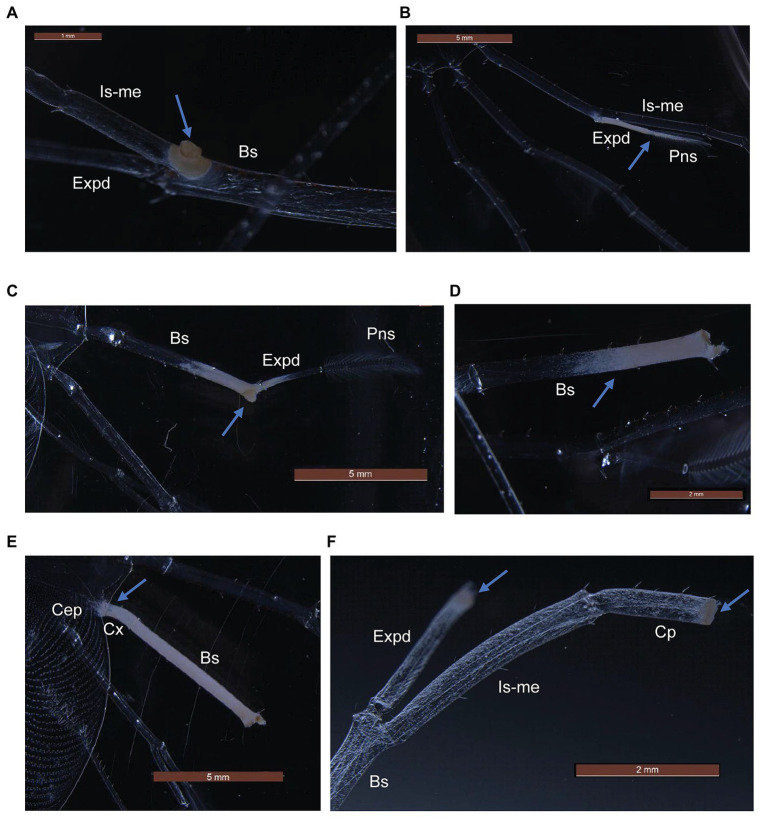
Gross pathological changes (arrows) during white leg disease (WLD) progression of P. ornatus
(A–E) and T. australiensis
(F) phyllosomas. (A) Pereiopod spot lesion at junction of basis (Bs), ischio-merus (Is-me) and exopod (Expd). (B) Advanced lesion of exopod and plumose natatory setae (Pns). (C) Detachment of pereiopod at junction of basis and ischio-merus. (D) Detachment of pereiopod and exopod at basis joint. (E) Creeping tissue whitening of pereiopod basis and coxa (Cx) segments and cephalic shield (Cep). (F) Spot lesions on carpus (Cp) and exopod of surgically damaged pereiopod (T. australiensis).